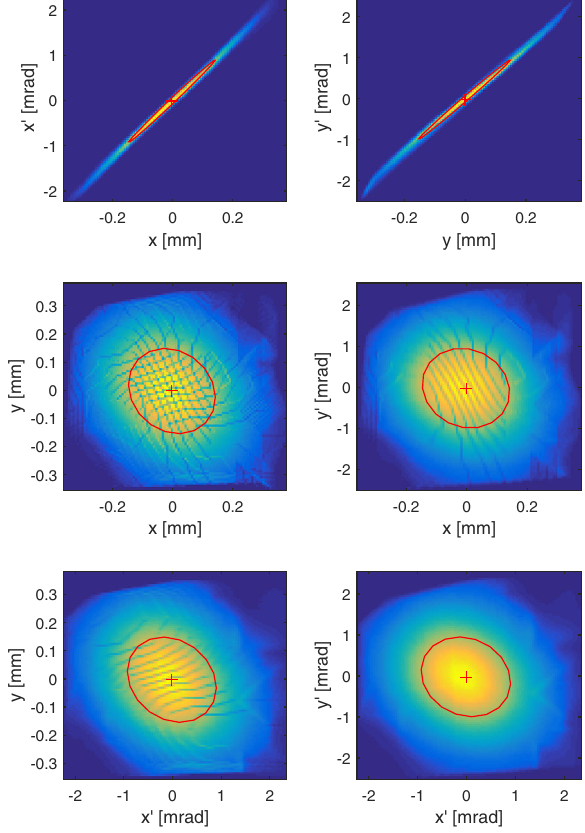
FIG. 11. Reconstructed 4D trace space density of a bunch measured with a TEM300 grid, shown as 2D projections of subspaces ð x; x 0 Þ , ð y; y 0 Þ , ð x; y Þ , ð x; y 0 Þ , ð x 0 ; y Þ and ð x 0 ; y 0 Þ .